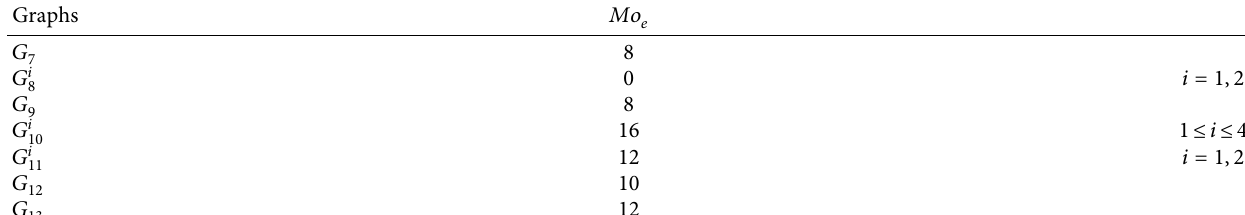
Table 4: The edge Mostar index of graphs in Figure 13.